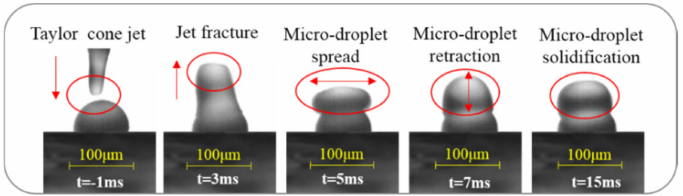
Figure 13. The process of droplet spreading, shrinking, and solidifying in vertical